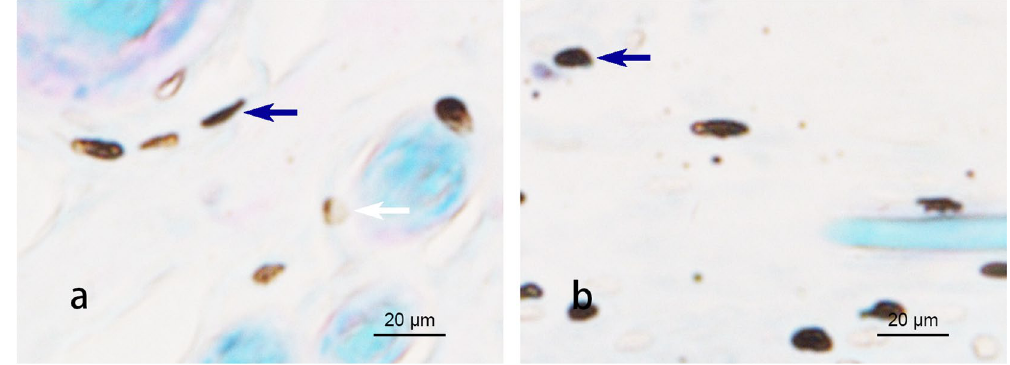
Figure 3. Degranulation of the mast cells in PC 6 after EA. ( × 400). The mast cells were stained with toluidine blue combined with safranine O. Note that after EA, the mast cells in PC 6 were degranulated, as shown by . In the Cro + EA group, most mast cells were stable without granules released, as shown by .